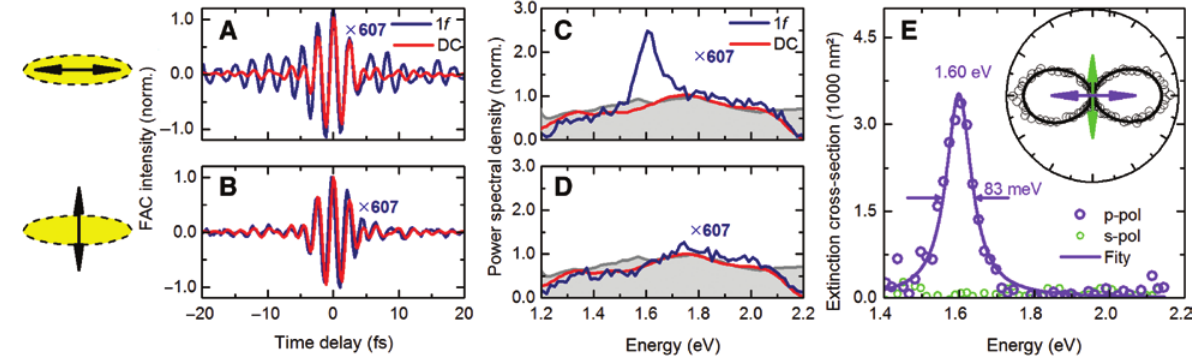
Figure 3: Experimental result of the FT-SMS measurement of a single gold nanorod. (A + B) Field autocorrelation functions of the measured power Δ P (red solid line) and the demodulated power Δ P dent polarization (A) parallel (p-pol) and (B) perpendicular (s-pol) to the longitudinal axis of the rod. (C + D) The power spectral densities of the field autocorrelation functions in (A) and (B). The laser spectrum is shown as a grey area. The corresponding normalization factors between the demodulated and the DC component are given. The peak at 1.60 eV in (C) is caused by the longitudinal SP resonance of the nanorod. (E) The background-corrected experimental extinction cross sections (circles) and Lorentzian fit (solid lines) for parallel (violet) and perpendicular (green) polarizations. Inset: The polarization dependence of the extinction cross section (open circles) and a cos 2 -fit (solid